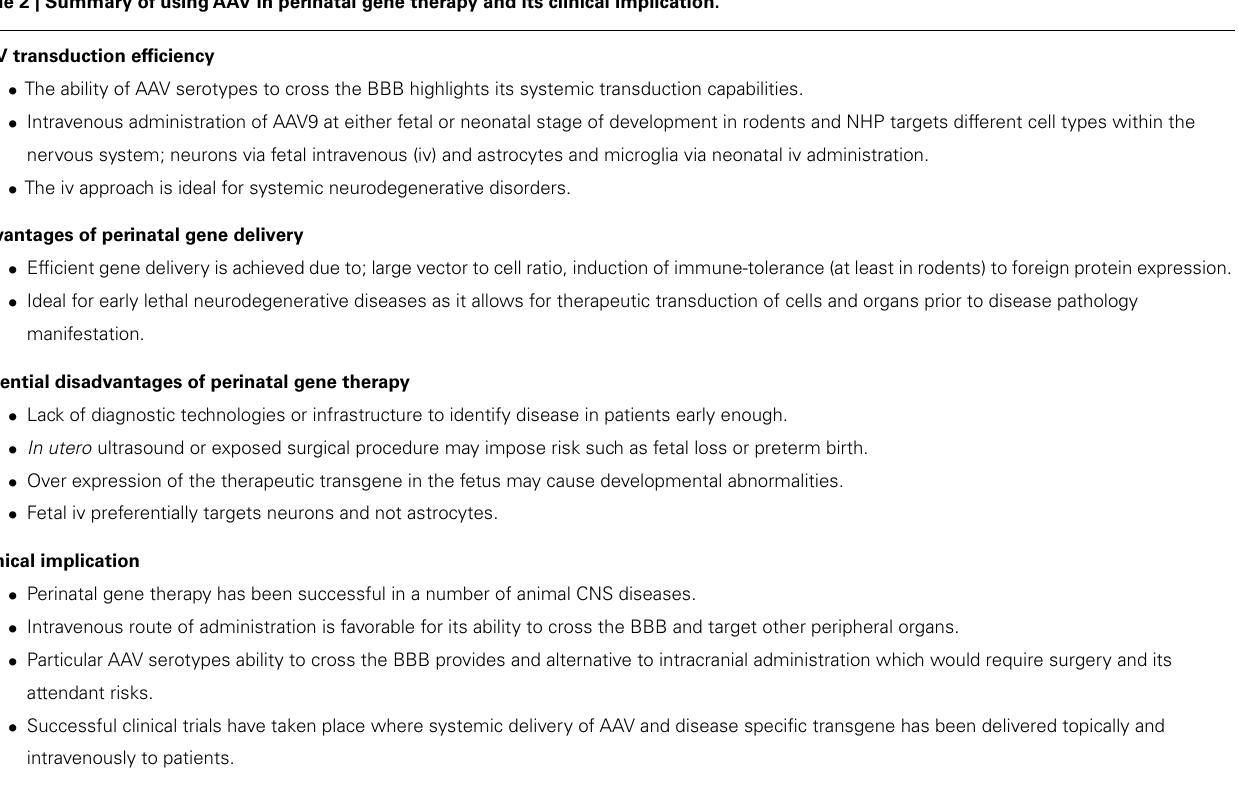
Table 2 | Summary of usingAAV in perinatal gene therapy and its clinical